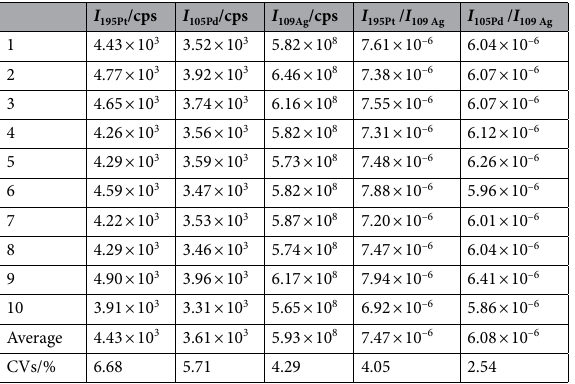
Table 6. Determined CVs of non-internal standard and internal standard LA-ICP-MS methods.